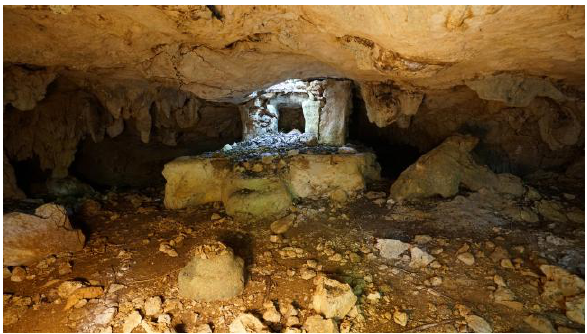
Figure 5. Shrine X-1. Note natural light from karst window in front of doorway. (Photo by D. Rissolo).